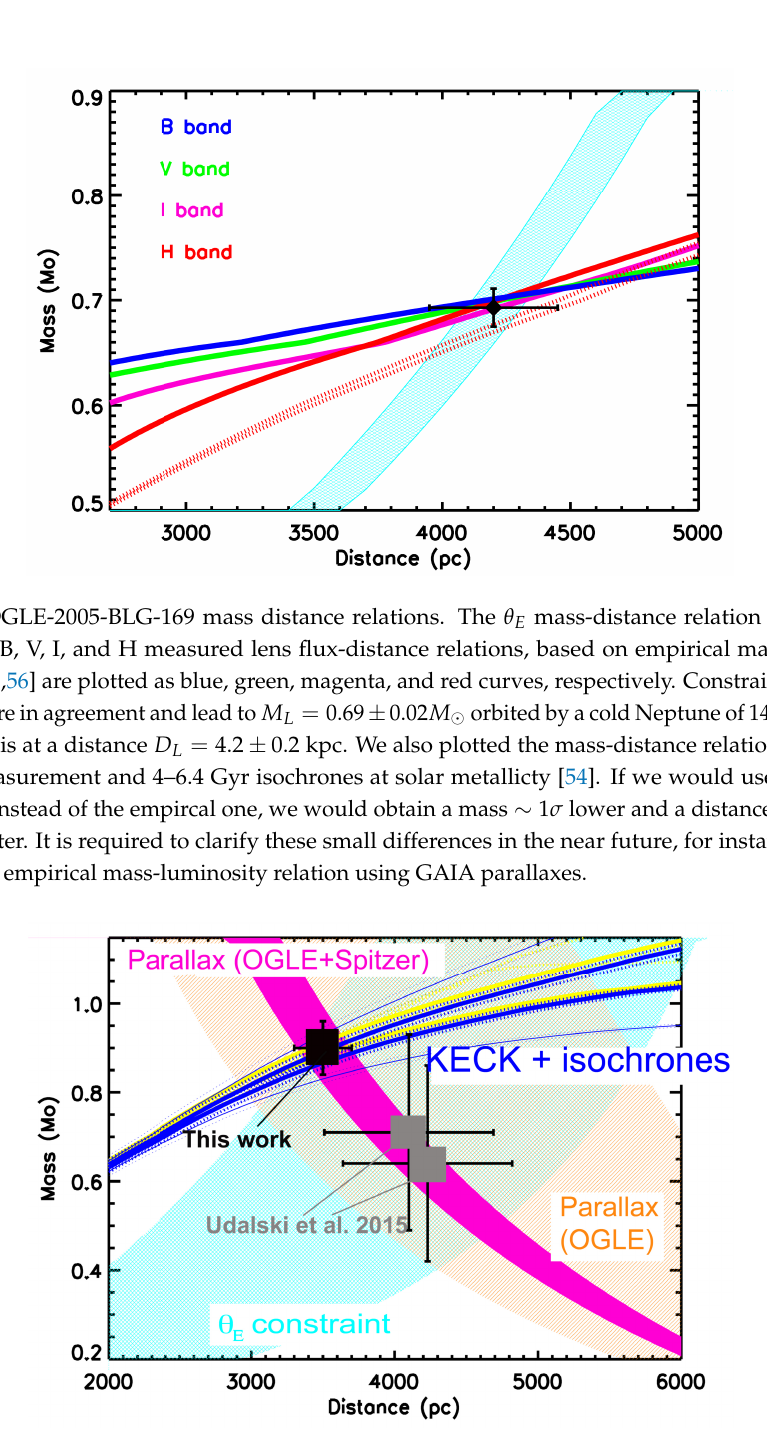
Figure 5. Mass-distance for the host star of the planetary microlensing OGLE-2014-BLG-0124. H-band isochrones in blue [54] for the H L = 16.63 ± 0.06 lens brightness, while K-band isochrones for H K = 16.44 ± 0.06 are plotted in yellow. The parallax mass-distance relation from OGLE alone is shown in orange, while the tight constraint from OGLE + Spitzer is plotted in magenta. The mass-distance from Einstein ring radius θ E estimate is shown in cyan. In this particular case, there were no caustic crossings, so it led to a poor constrain from θ E . The grey squares mark the mass and distance estimates for the two solutions presented in the discovery paper [49], while the black square with its error bar is obtained after adding the KECK AO constraints